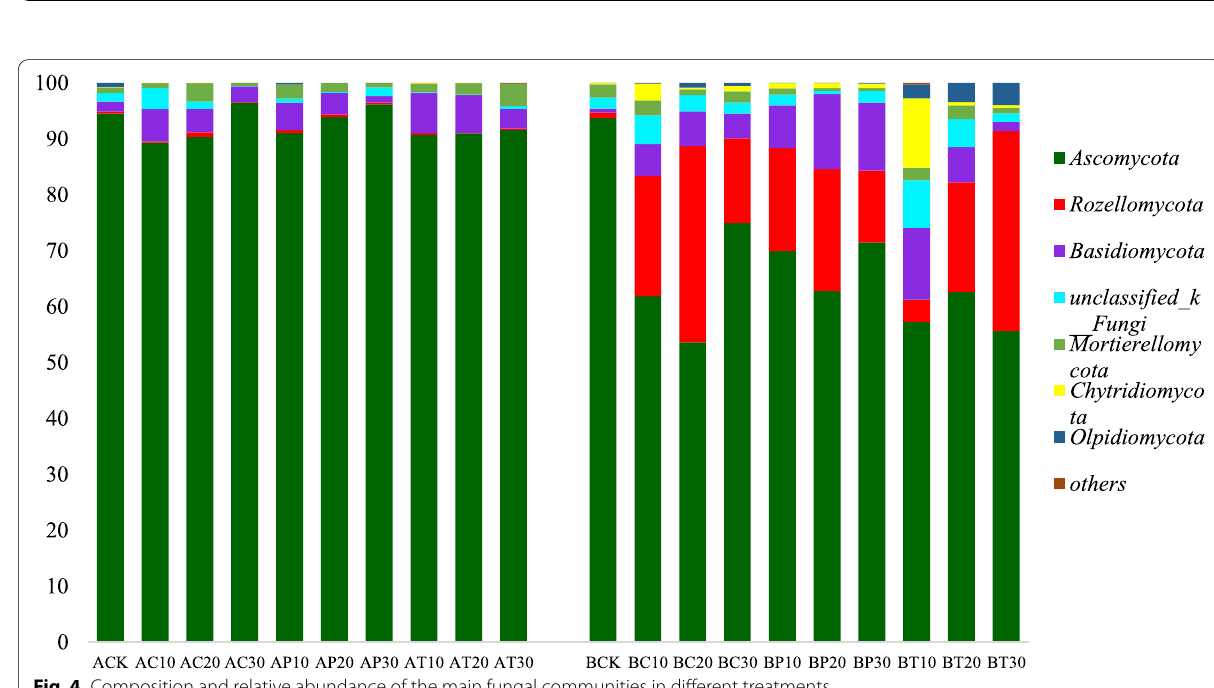
Fig. 4 Composition and relative abundance of the main fungal communities in different